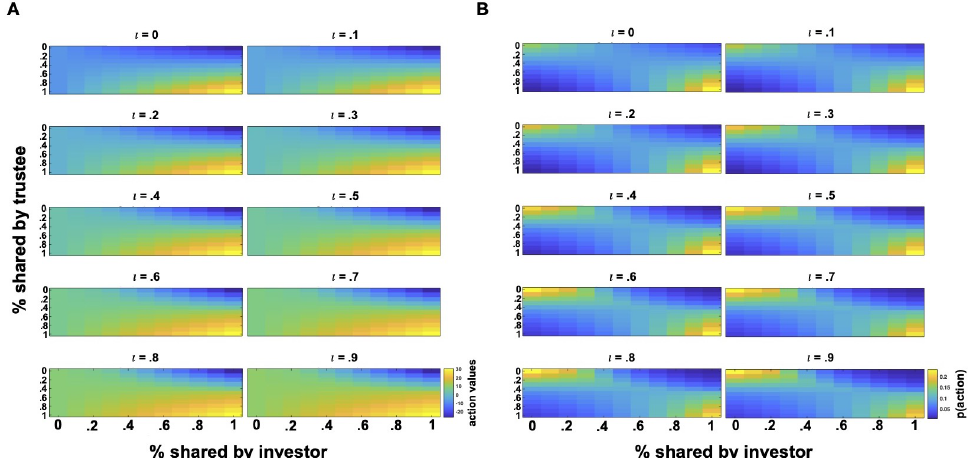
Figure 3. Action values and probabilities with varying ι . Action values ( A ) and action probabilities ( B ) for investors with different ι parameters (i.e., envy or disadvantageous inequality) as computed according to the inequity aversion model. In all plots, ζ is set to 0. For action probability estimation, the χ parameter of investors’ policy is set to